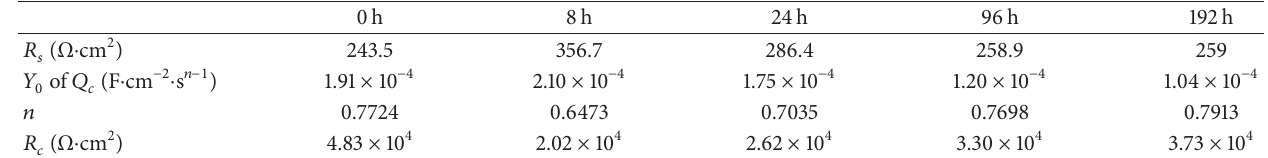
Figure 8: Time evolution of 𝑄 𝑐 and 𝑅 𝑐 of painted samples with scratch values calculated from EIS spectra. Table 4: Impedance value of painted samples with scratch calculated from EIS spectra.